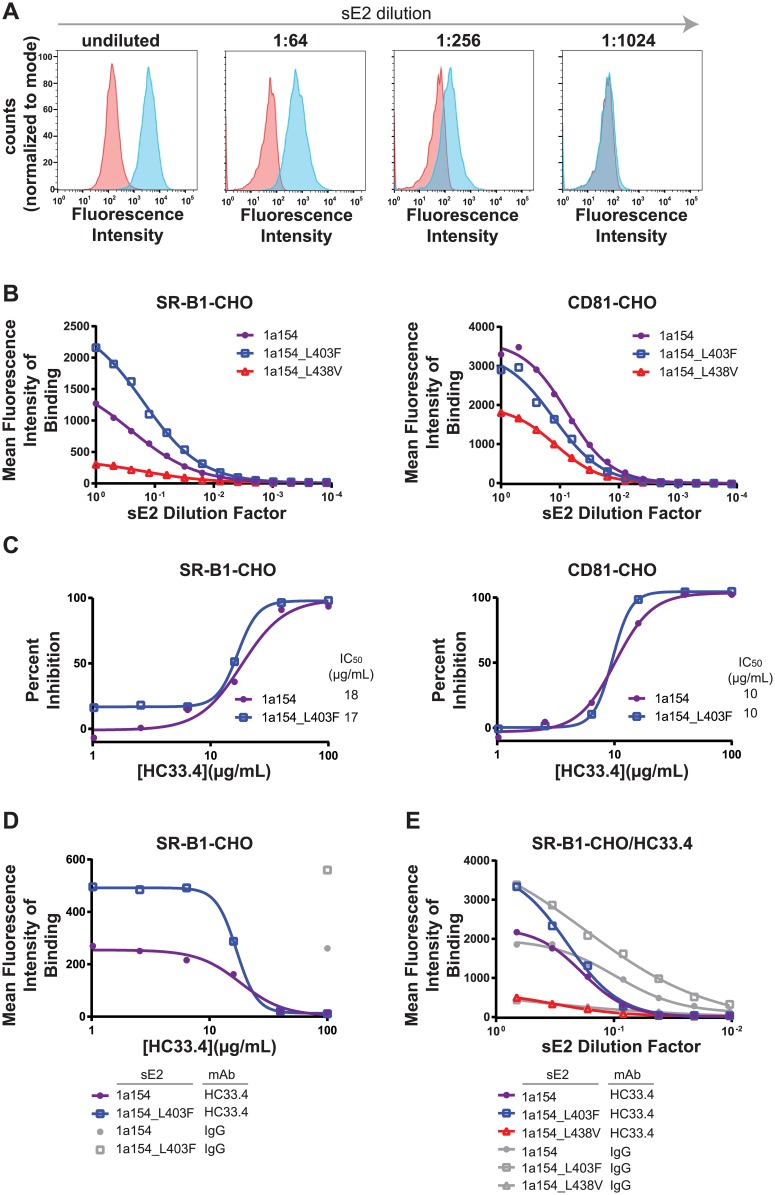
L403F and L438V modulate bNAb resistance by altering binding to SR-B1.(A) Binding of serial dilutions of strain 1a154 (H77) soluble E2 (sE2) to CHO cells expressing human CD81 (blue peaks) or to wild type CHO cells that do not express HCV receptors (pink peaks), measured by flow cytometry. (B) Binding of serial dilutions of 1a154, 1a154_L403F, or 1a154_L438V sE2 to SR-B1-CHO cells or CD81-CHO cells. Each point was calculated from 10e4 events. Background binding to wild type CHO cells was subtracted from mean fluorescence intensity (MFI) values. sE2 supernatants were normalized for relative sE2 concentration (shown in S3 Fig) prior to dilution. One experiment that is representative of two independent experiments is shown. The second experiment is shown in S4 Fig. (C) Percent inhibition of sE2 binding to SR-B1 or CD81 by HC33.4. MFI of binding of a fixed, equivalent concentration of 1a154 or 1a154_L403F sE2 to SR-B1-CHO or CD81-CHO cells in the presence of serial dilutions of mAb HC33.4 or nonspecific human IgG was used to calculate percent inhibition of binding. Each point was calculated from 10e4 events. Background binding to wild type CHO cells was subtracted from mean fluorescence intensity (MFI) values. IC50 was calculated by nonlinear regression. (D) Binding of equivalent concentrations of sE2 to SR-B1-CHO cells in the presence of serial dilutions of HC33.4. Each point was calculated from 10e4 events. Background binding to wild type CHO cells was subtracted from mean fluorescence intensity (MFI) values. Binding after incubation of each sE2 with 100 μg/mL of nonspecific IgG is shown for reference. (E) Binding of serial dilutions of 1a154, 1a154_L403F, or 1a154_L438V sE2 to SR-B1-CHO cells after preincubation of sE2 with 40 μg/mL of HC33.4. Each point was calculated from 10e4 events. Background binding to wild type CHO cells was subtracted from mean fluorescence intensity (MFI) values. sE2 supernatants were normalized for relative sE2 concentration prior to dilution.